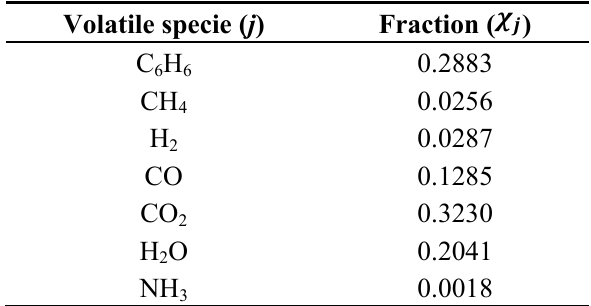
Table 3. Fraction of the released volatile